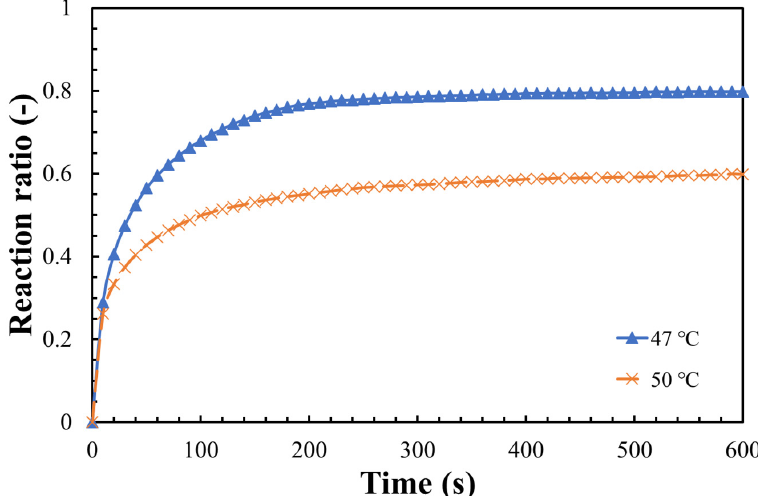
Figure 8. Effect of steam pressure on the hydration reaction rate (conditions C and D).